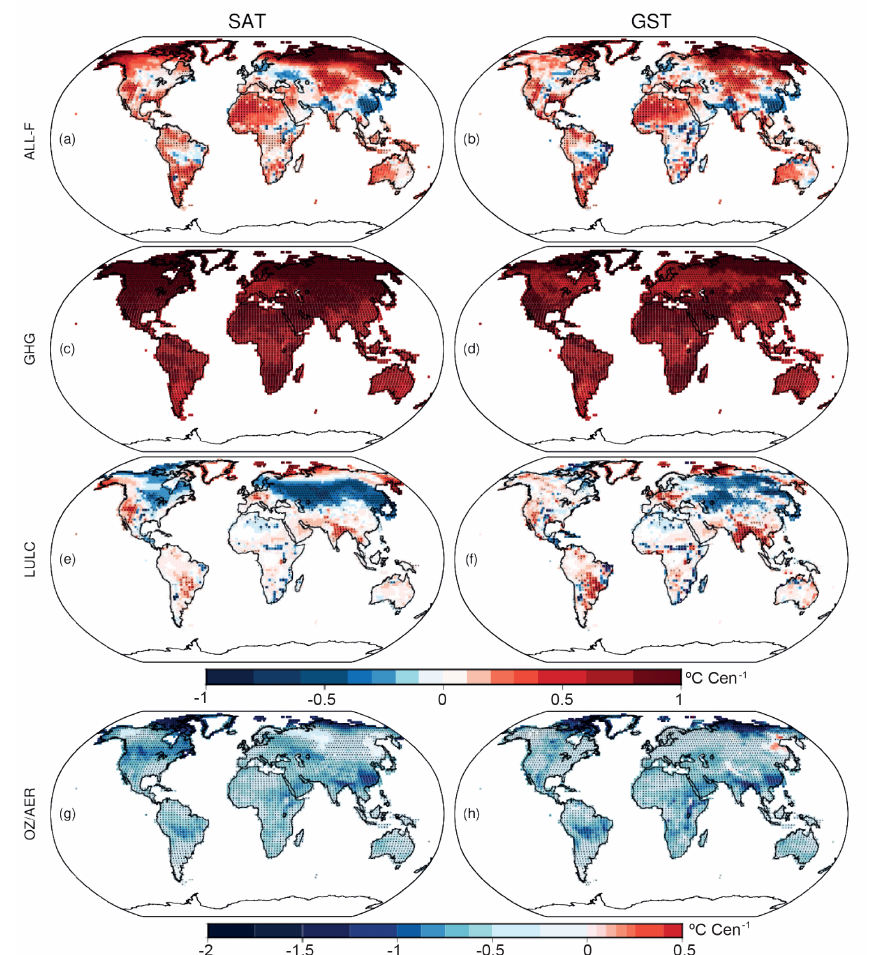
Figure 8. Spatial distribution of the linear trends in the industrial period for the ALL- F (a, b) , GHG-only (c, d) , LULC-only (e, f) and OZ/AER-only (g, h) ensembles for SAT (a, c, e, g) and GST (b, d, f, h) . Trends are indicated in Celsiuscentury − 1 . Dots indicate that 80% of the ensemble members agree in delivering significant trends at a grid point in the case of the ALL- F ensemble. For the GHG-only and LULC-only ensembles, dots indicate that at least two of the three ensemble members agree in delivering significant trends for a grid point, whereas for the OZ/AER-only dots indicate that both of the ensemble members deliver significant trends. Note the different scale for